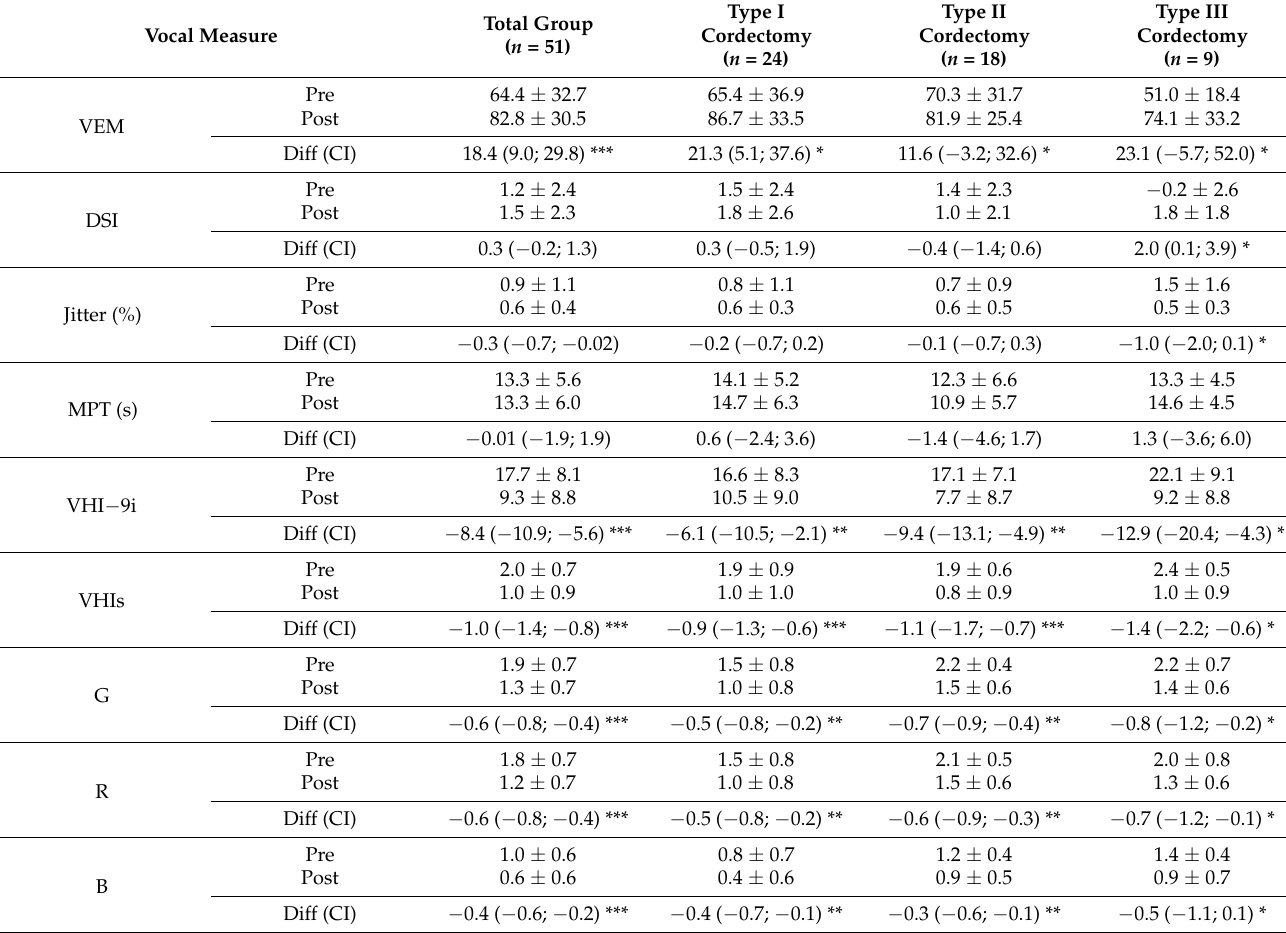
Table 2. Pre- and posttherapeutic parameters of vocal function in all patients and all cordectomy types (mean ± SD), their mean therapeutic differences (Diff) and 95% confidence intervals (CI) for changes in vocal measures three months after pT1a